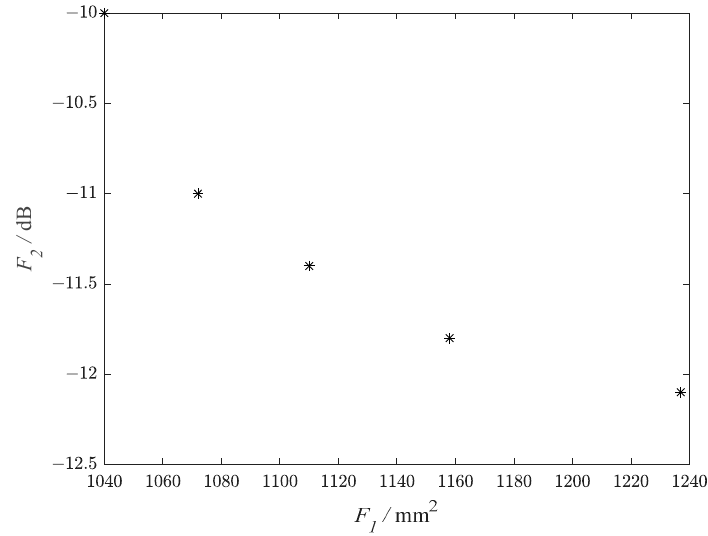
Figure 11. Pareto Front of the planar tri-band antenna. Table 5. Optimal size parameters of the tri-band antenna (unit: mm).